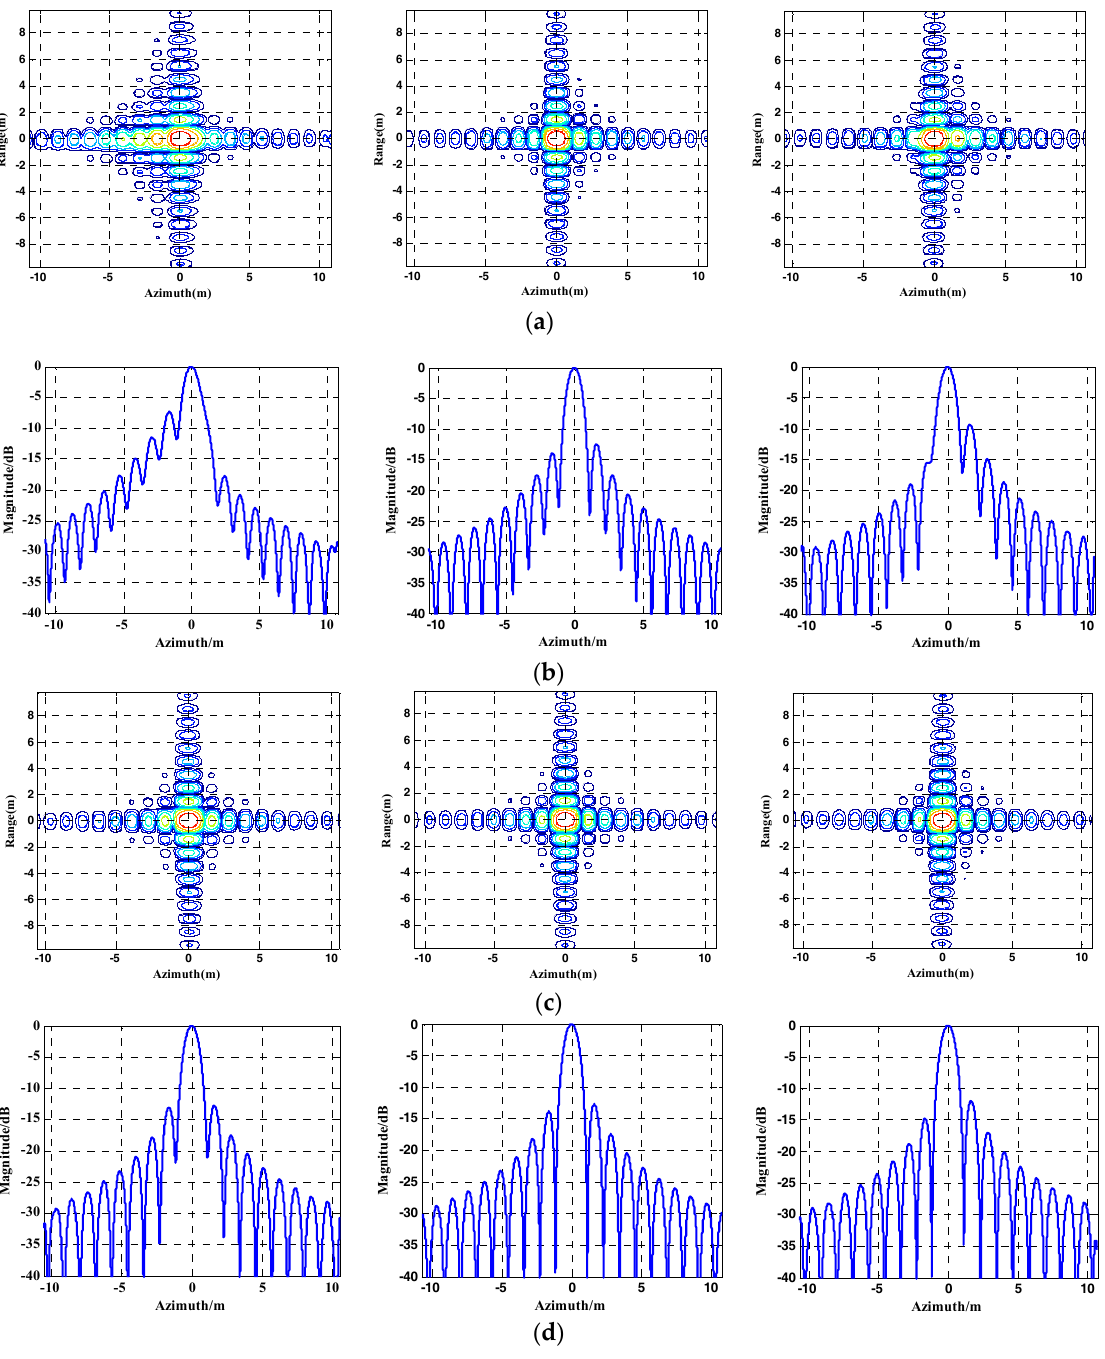
Figure 5. Simulation results processed by different algorithms. The sub-images in each column correspond to target 1, target 2, and target 3, respectively. ( a , c ) and ( b , d ) show the contours azimuth slice of the results processed by the extended nonlinear CS algorithm (ENLCSA) and generalized nonlinear chirp scaling (GNLCSA), respectively.